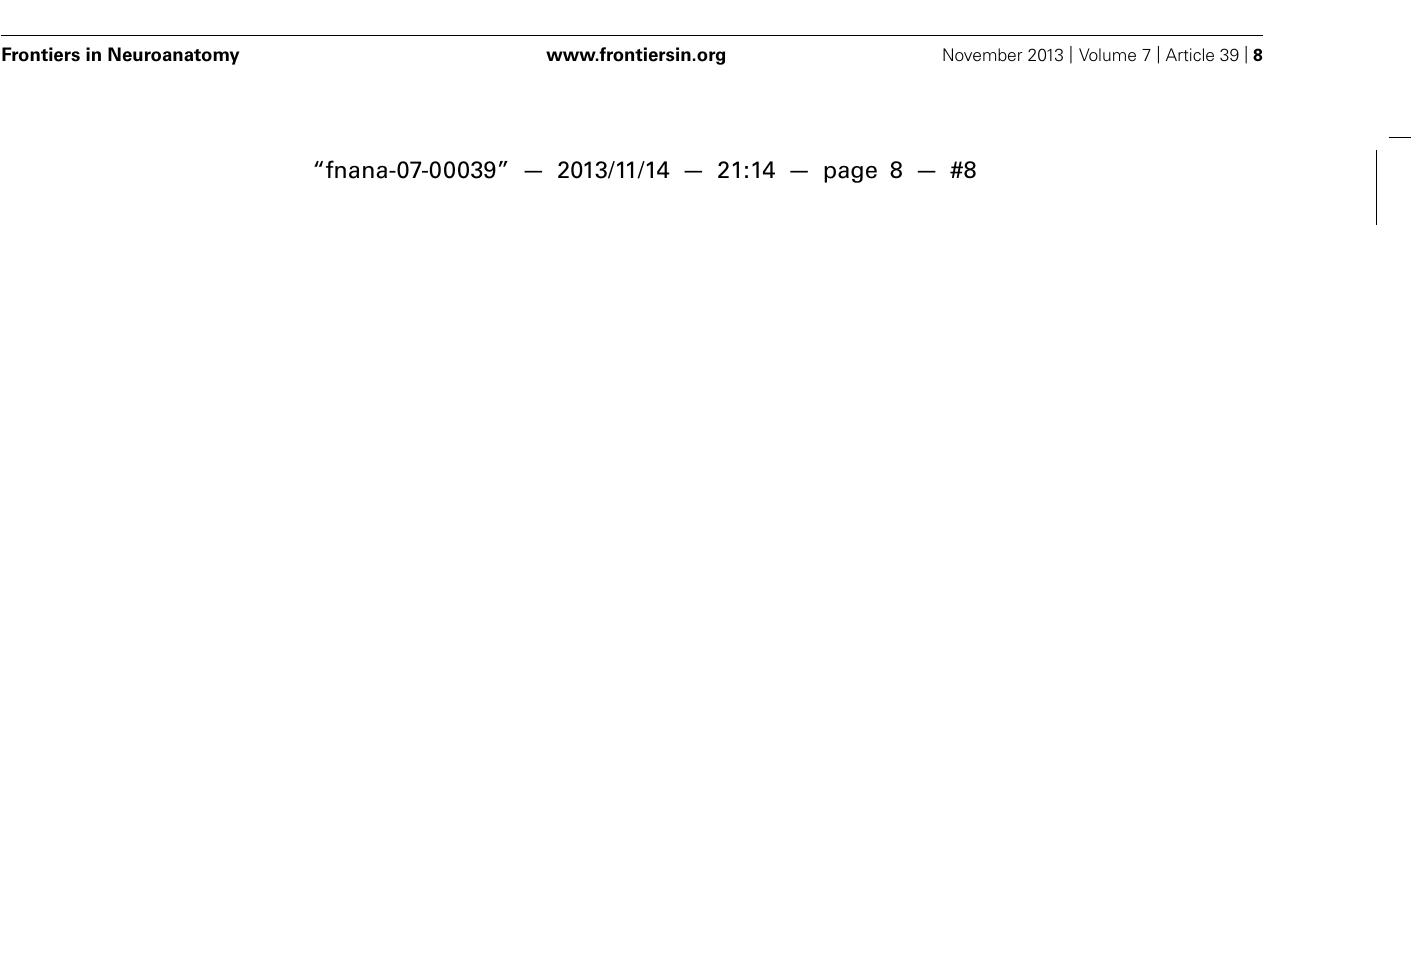
FIGURE 5 |Topography of the naked mole-rat cerebellum with electrophysiological mapping of cutaneous and periodontal responses from the lateral extent of lobulus simplex B and the ansiform lobule. (A) Schematic of the microelectrode-derived map of cutaneous inputs to the cerebellum labeled according to corresponding receptive fields. Dark circle